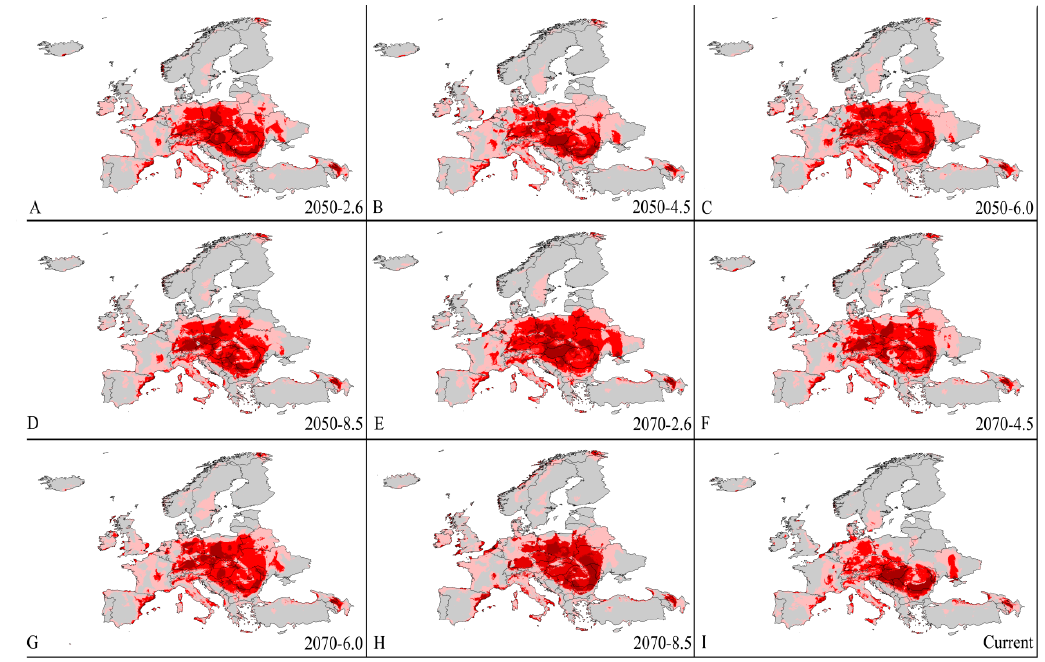
Figure 7. Future potential suitable habitats of Pseudaulacaspis pentagona on the Europe continent under different climate scenarios predicated by MaxEnt. Gray, unsuitable habitat area; Pale red, low habitat suitability area; Red, moderate habitat suitability area; Dark red, high habitat suitability area. ( A ) RCP 2050-2.6; ( B ) RCP 2050-4.5; ( C ) RCP 2050-6.0; ( D ) RCP 2050-8.5; ( E ) RCP 2070-2.6; ( F ) RCP 2070-4.5; ( G ) RCP 2070-6.0; ( H ) RCP 2070-8.5; ( I ) Current.